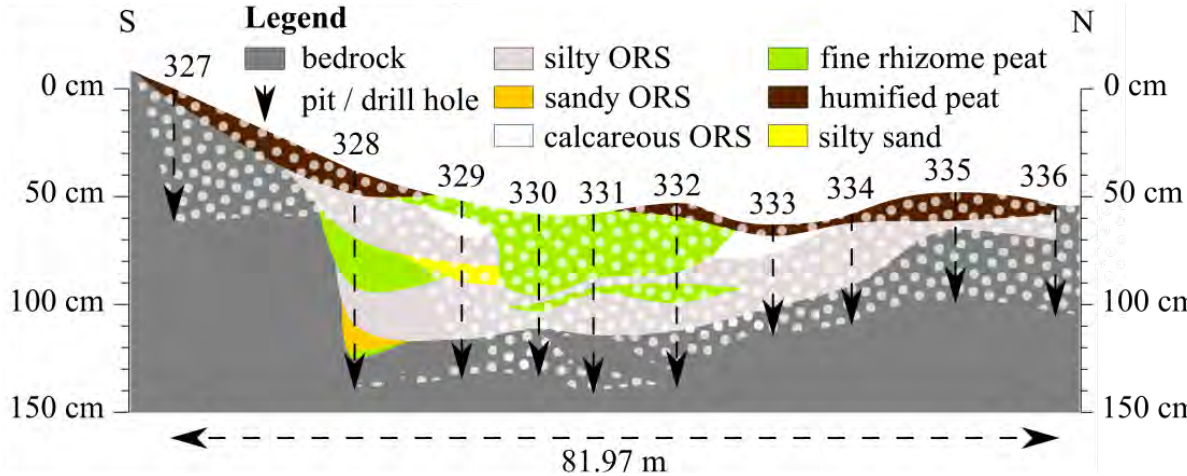
Figure 10. Stratification of the Arpa Peatland. White dots mark layers which contain